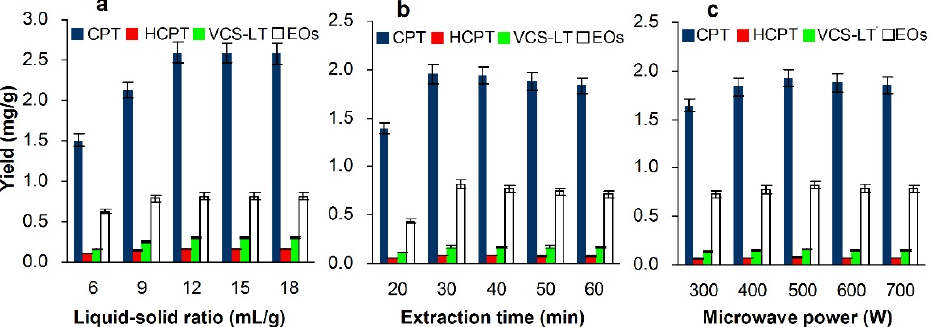
Figure 5. Effects of liquid–solid ratio ( a ); extraction time ( b ); and microwave power ( c ) on yields of CPT, HCPT, VCS ‐ LT, and EOs.